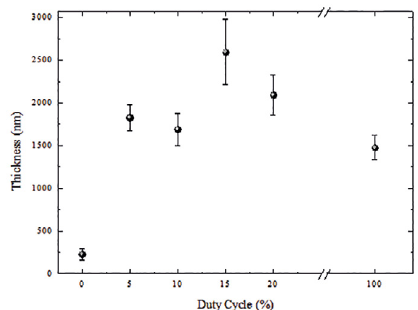
Figure 1. Thickness of the films as function of the duty cycle of the pulses. The result obtained for the sample prepared with the grounded sample holder is presented in Δ =